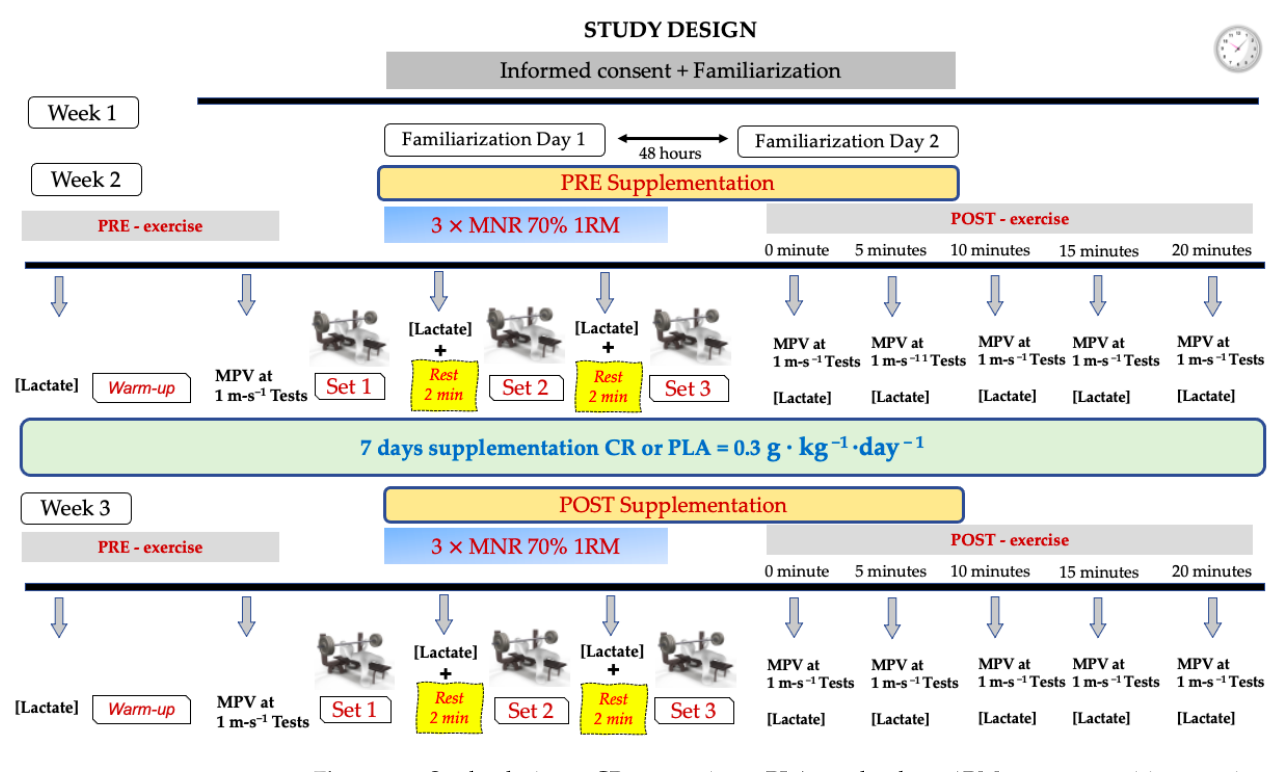
Figure 1. Study design. CR = creatine. PLA = placebo. 1RM = one repetition maximum. MNR = maximum number of repetitions. MPV = Mean Propulsive Velocity.